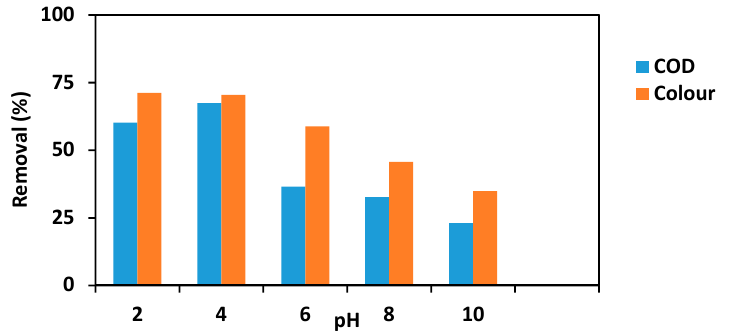
Figure 2. Effect of pH on photocatalytic degradation (process conditions: TiO 2 dosage—500 mg/L, reaction time—3 h, UV light irradiation—64 W).